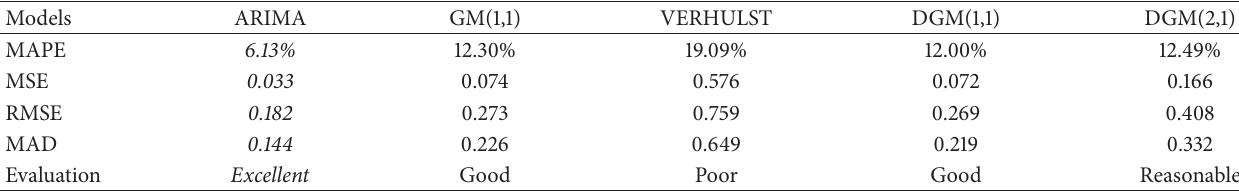
Table 9: Evaluating models with RMP forecasting